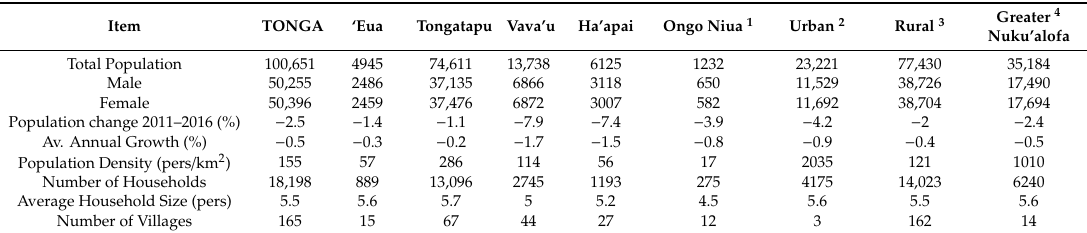
Table 1. Summary of 2016 population statistics for Tonga as a whole, for island Divisions, for urban, rural areas and for greater Nuku’alofa populations